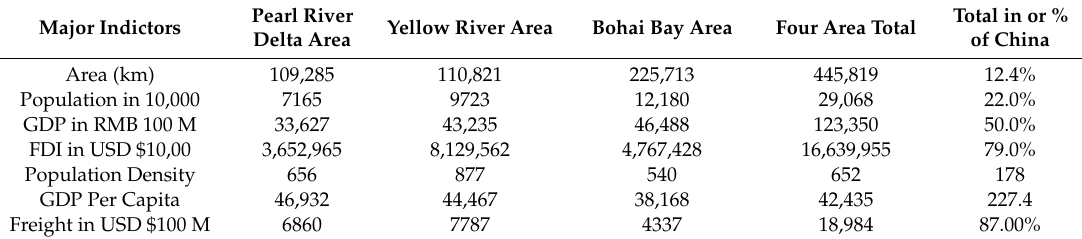
Figure 10. Google Earth 3D views of U.S.–China import and export freight flows, 2009. Table 5. Top Indictors by port clusters in Bohai, Yangtze River, and Pearl River areas,